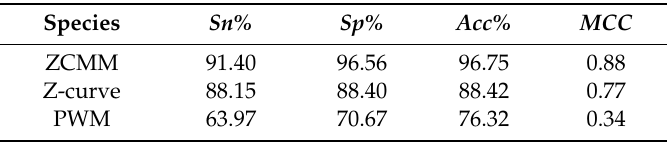
Table 1. 10-fold cross-validation of di ff erent methods.